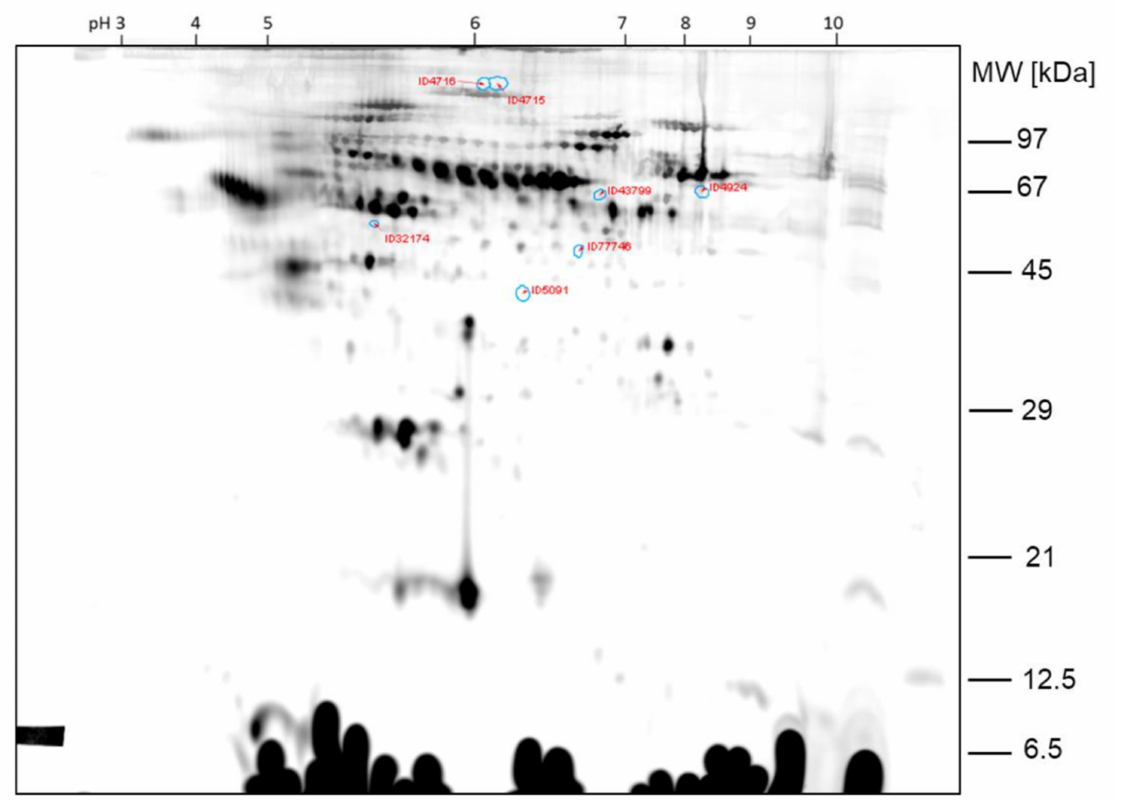
Figure 2. Comparison 1: Spots found >2-fold higher expressed in sample